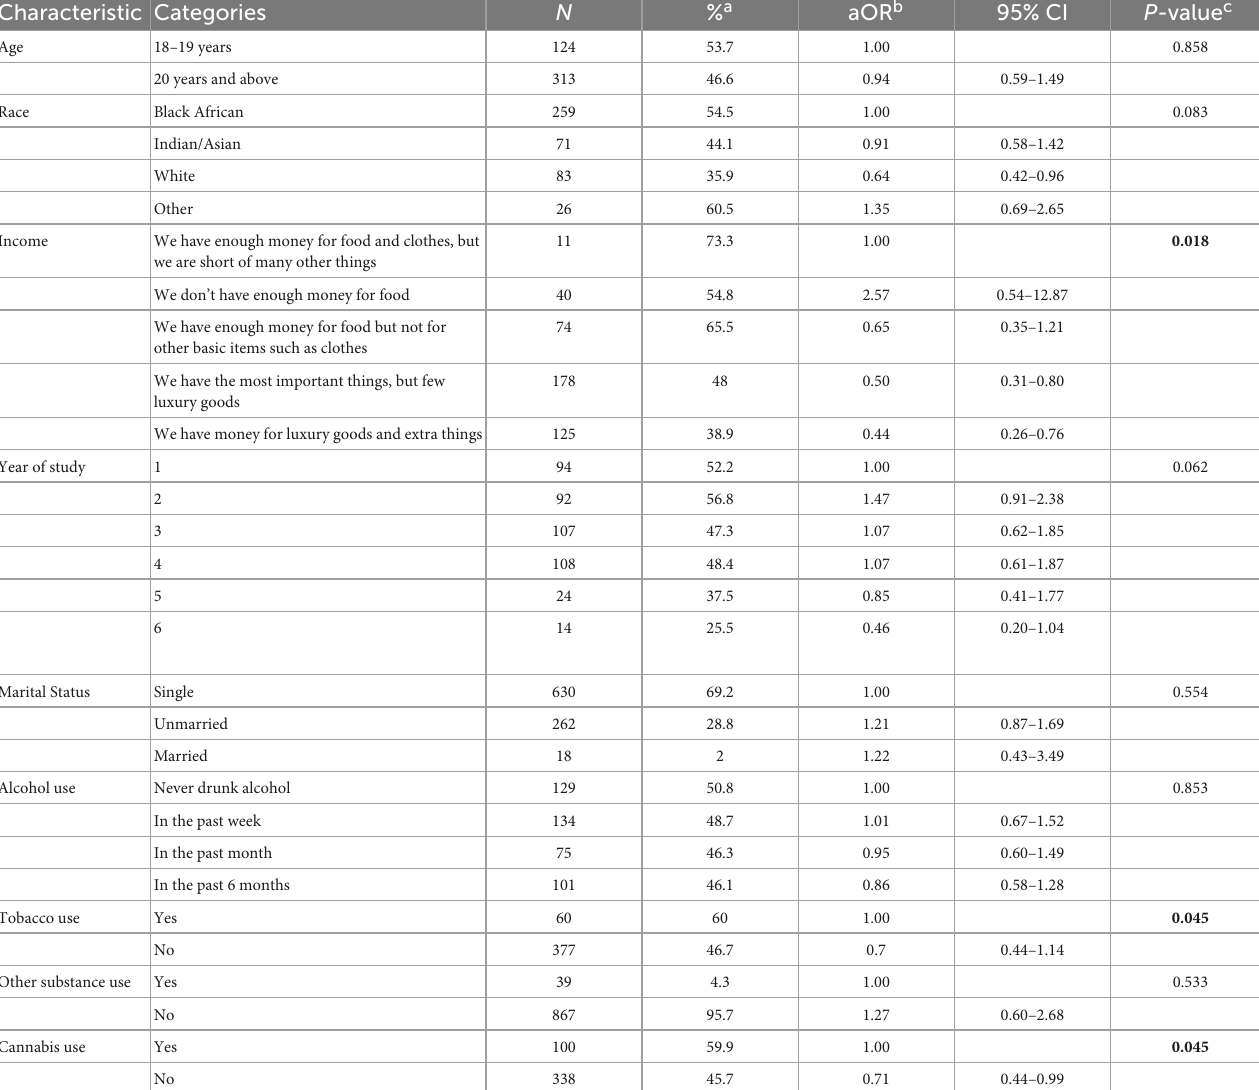
TABLE 3 Factors associated with screening positive for probable depression (in multivariable analysis) among the University of Witwatersrand undergraduate students ( N = 908) who participated in the survey February–May 2021. Characteristic